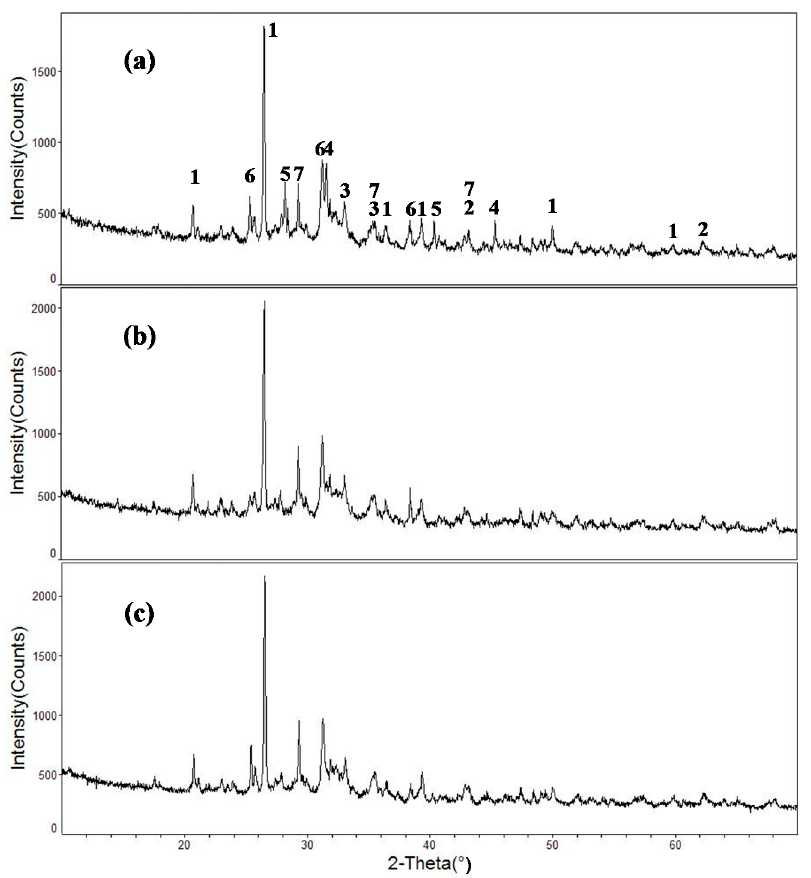
Figure 5. X patterns of APC residue before and after washing: ( a ) untreated APC residue; ( b ) first washed APC residue; ( c ) twice washed APC residue. 1: SiO 2 ; 2: MgO; 3: Fe 2 O 3 ; 4: NaCl; 5: KCl; 6: CaSO 4 ; 7: CaCO 3 .